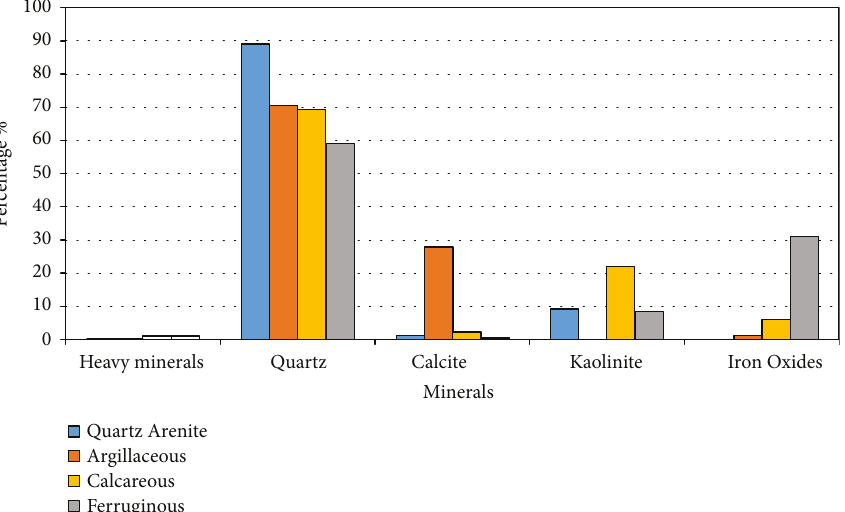
Figure 2: XRD results of the drilled cuttings (core samples).